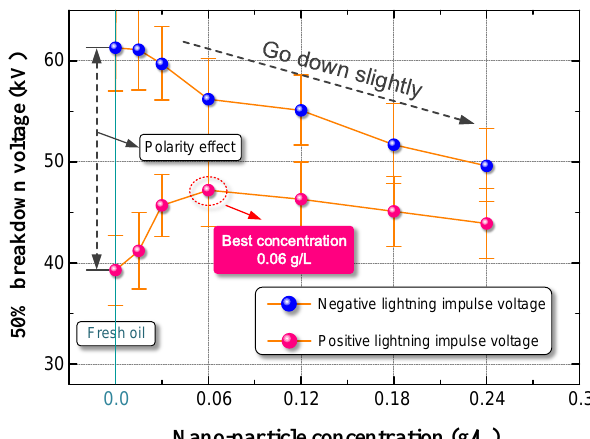
Figure 5. The 50% breakdown voltage (U 50 ) of fresh transformer oil (FTO) and nano-modified transformer oil (NMTO) under standard lightning impulse voltage.